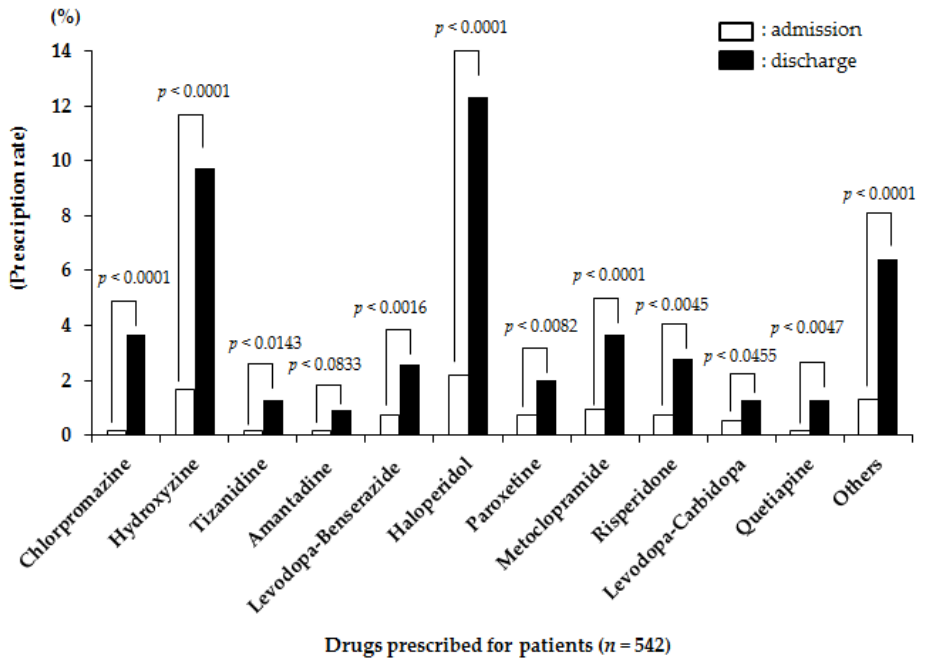
Figure 2. Comparison of the ratio for anticholinergic prescriptions between admission and discharge. Table 4. Subgroup analysis of main